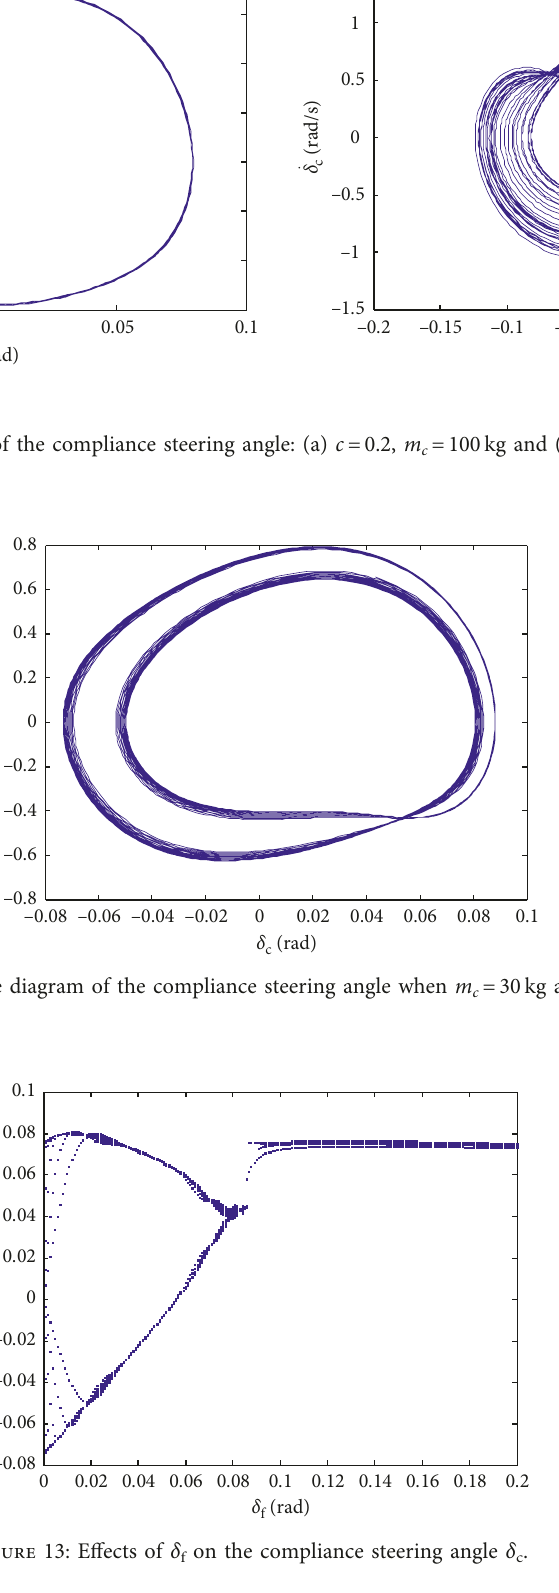
Figure 13: Effects of δ f on the compliance steering angle δ c